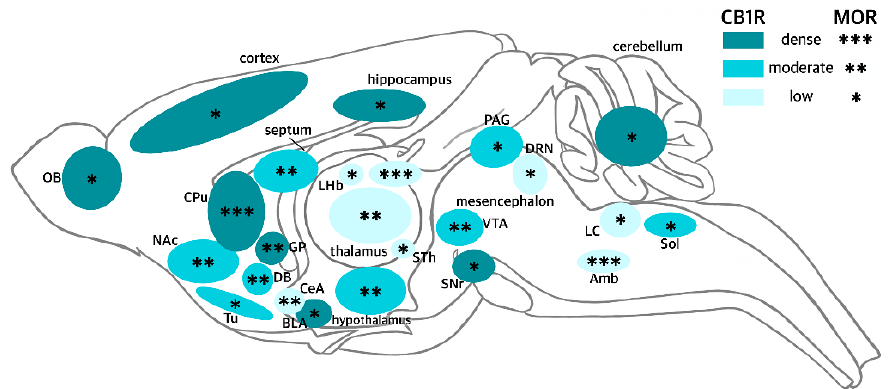
Scheme 2. Schematic representation of CB1R and MOR distribution in the rat brain. Figure taken from Befort [36] under the terms of the Creative Commons Attribution License (CC BY). Authors ’ own modification. The distribution of CB1Rs and MOR is indicated by number of stars with a low